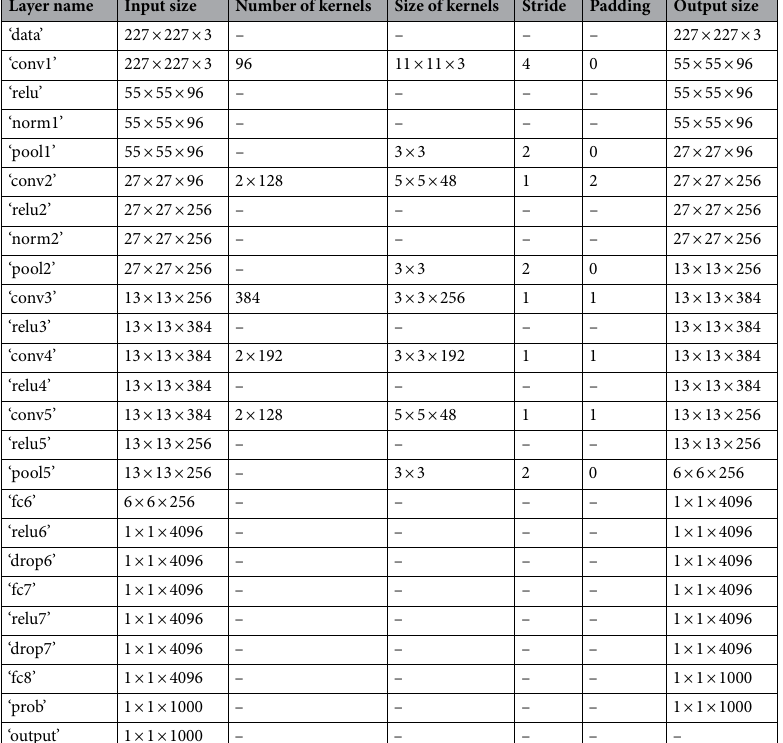
Table 3. Pre-trained AlexNet model